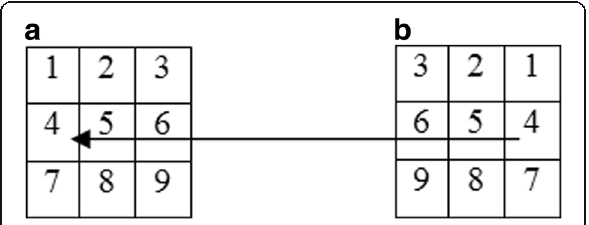
Fig. 6 Filling of the most similar symmetrical exemplar of 3 × 3 in the 0 direction. a Target patch. b Most similar symmetrical